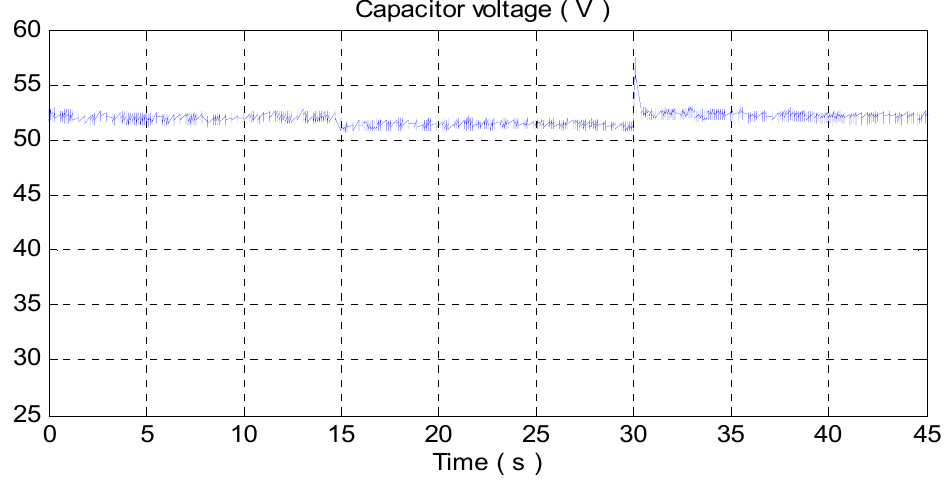
Figure 22. Capacitor voltage v c .